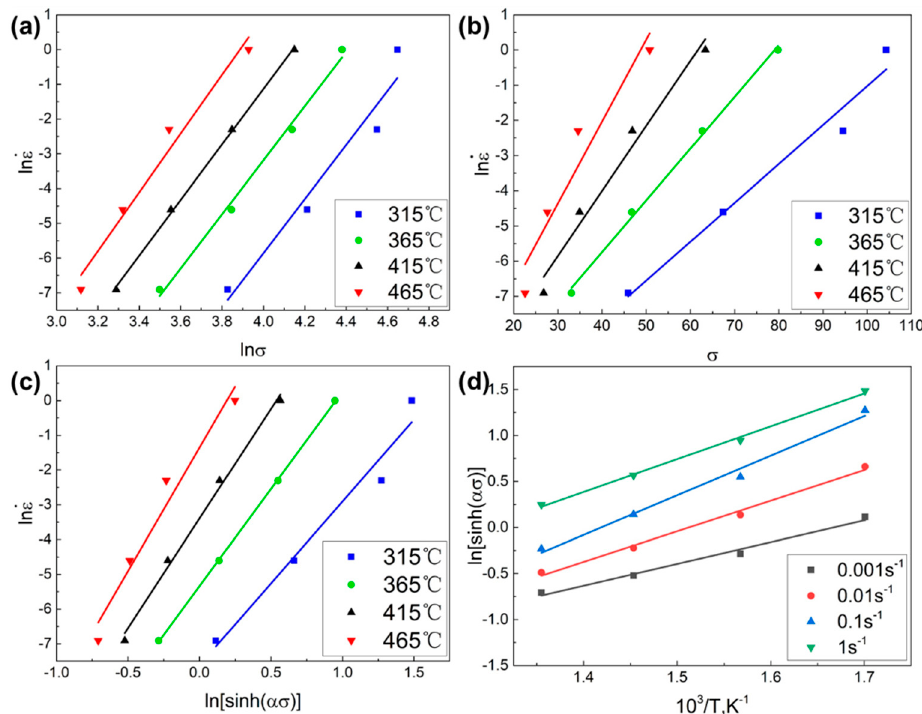
Figure 10. The relationship between the peak stress, strain rate and deformation temperature in the second layer of the deposited alloy: ( a ) ln ε ˙ ‐ ln σ s , ( b ) ln ε ˙ ‐ σ s , ( c ) ln ε ˙ ‐ ln[sinh( ασ )], ( d ) ln[sinh( ασ )] ‐ 1/T.